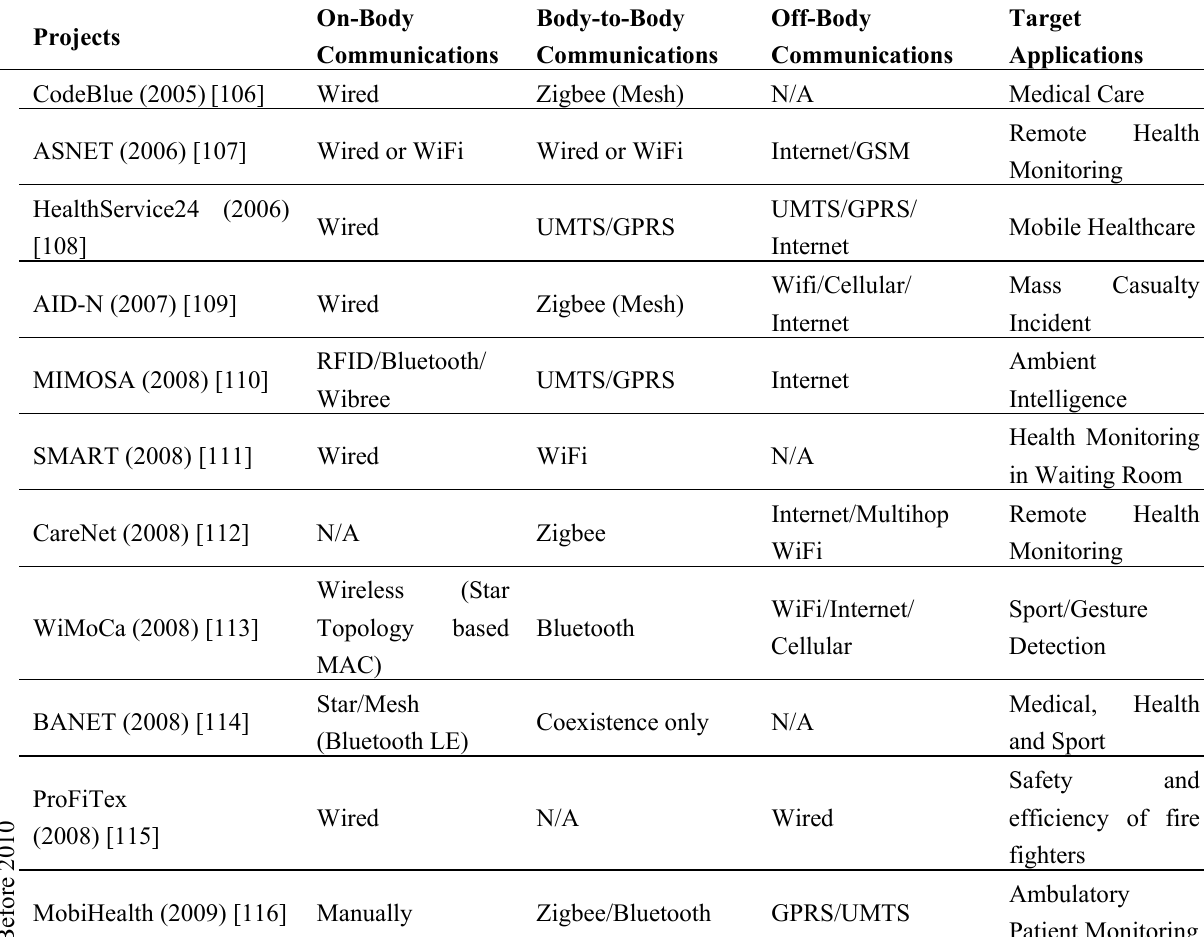
Table 13. Comparative Study on Existing WBANs